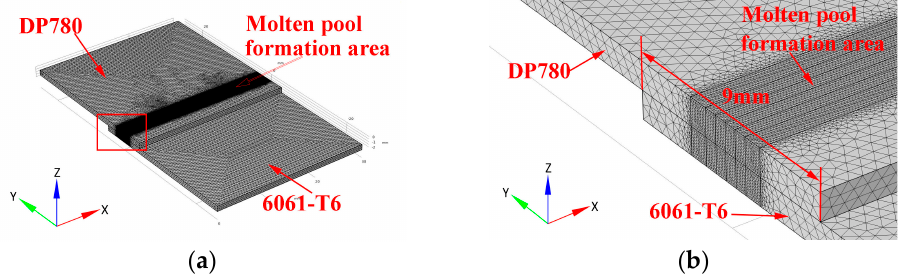
Figure 2. The appearance of the object mesh in the numerical model. ( a ) Overall view; ( b ) partially enlarged view of the red frame area in Figure 2a.